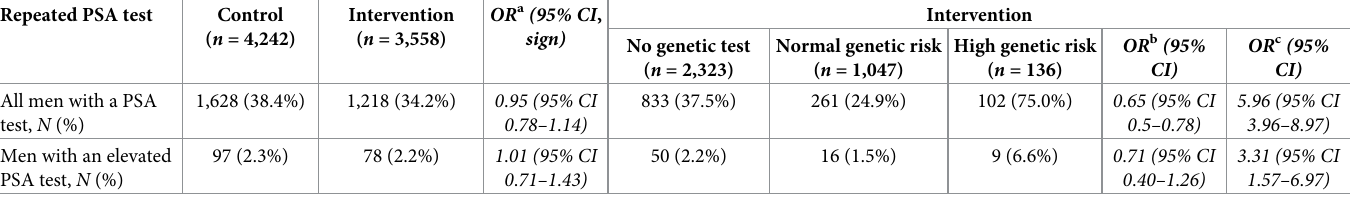
Table 2. Unadjusted primary and secondary outcomes after 2 years’ follow-up. Repeated PSA